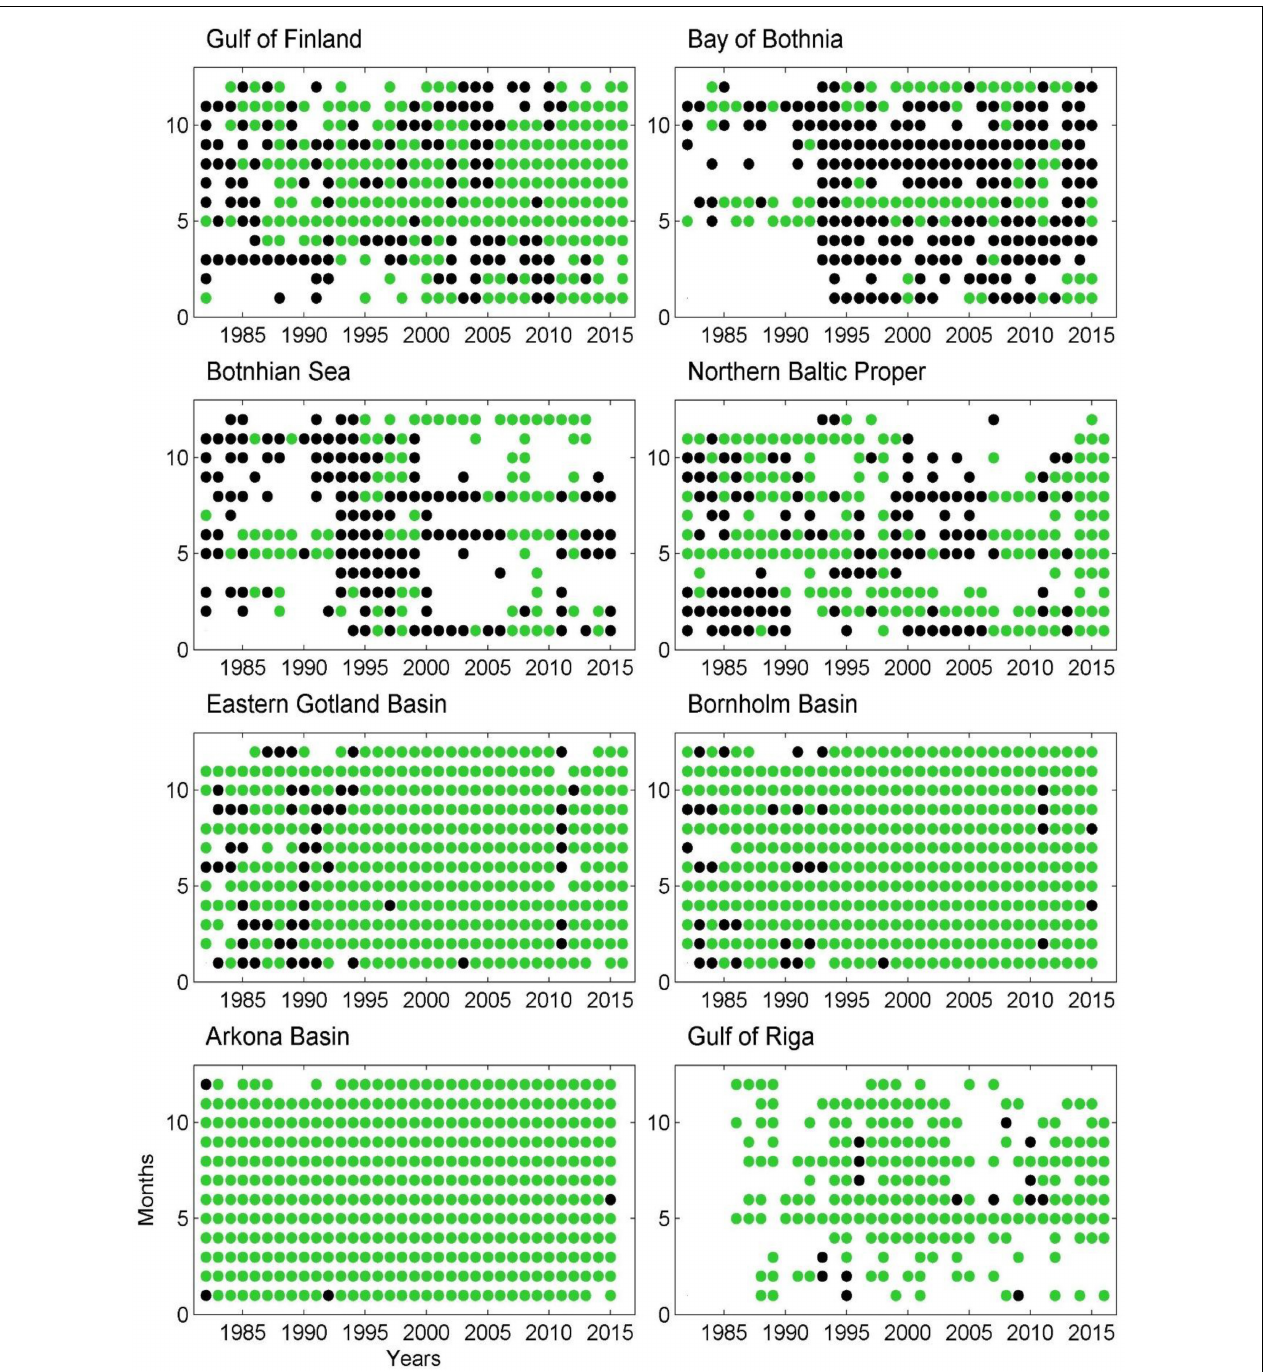
FIGURE 2 | Availability of the data in the eight selected locations. Black dots show the month/year when the data were available at least from the surface layer and green dots indicate the month/year when the data were available throughout the entire water